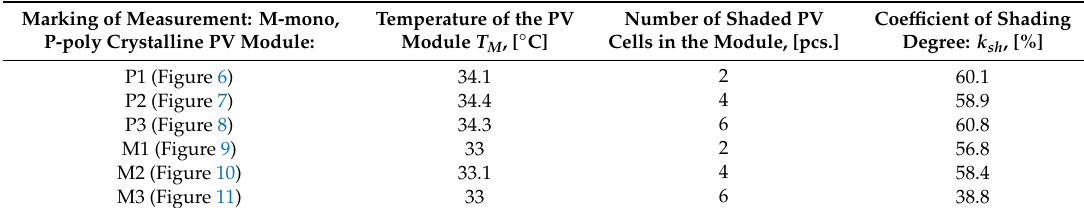
Table 2. Conditions of experimental measurements, performed with the I–V 400 meter on 13 October 2018, between 10 and 12 p.m., with an average ambient temperature of 14.5 ◦ C.